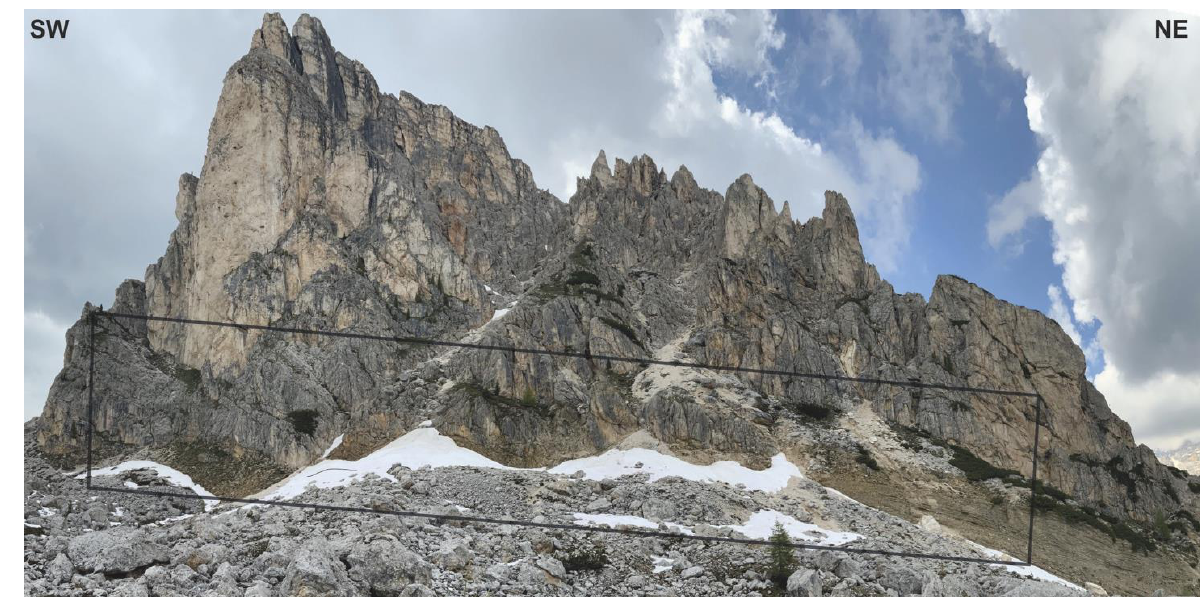
Figure 3. Photograph of the study area (Gusela del Nuvolau cliff). The carbonate body contains dolomitic and calcitic units, but these cannot be distinguished using the naked eye. Cliff is 250 – 300 m high and 600 m long. The grey rectangle shows the approximate extent of the hyperspectral sur- vey.